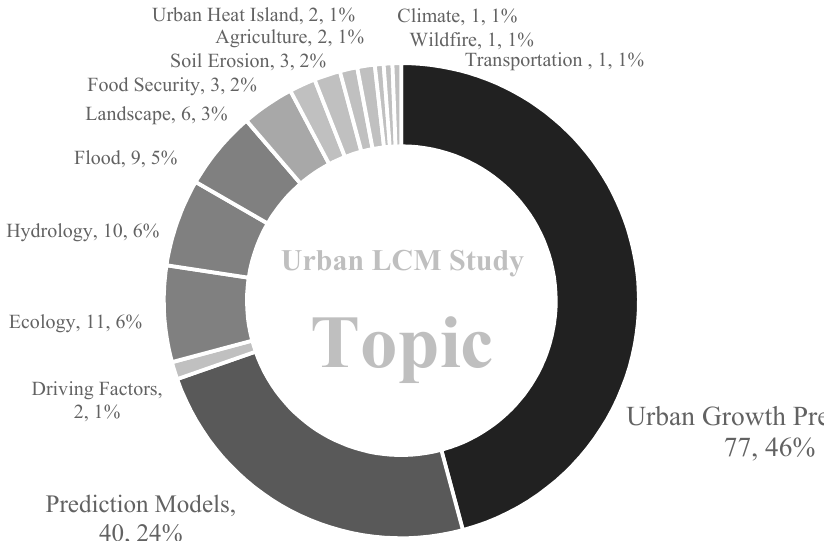
Figure 3. Topics in the reviewed articles*. (*When an article aims to evaluate a subsequent impact due to urban growth prediction, its topic is classified as the growth-related topic (e.g., ecology, hydrology, flood).)